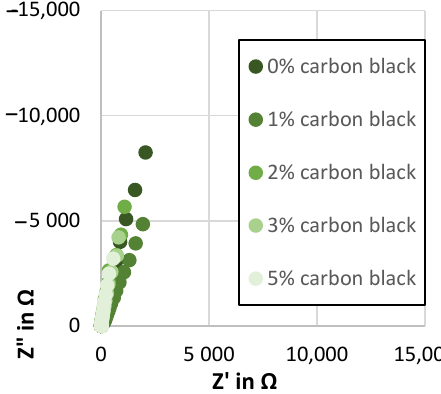
Figure A2. Starting real impedance of the Kuranode hard carbon electrodes according to the conduc- tive additive content, as measured with the electrolyte containing DMC as a low-viscosity solvent.